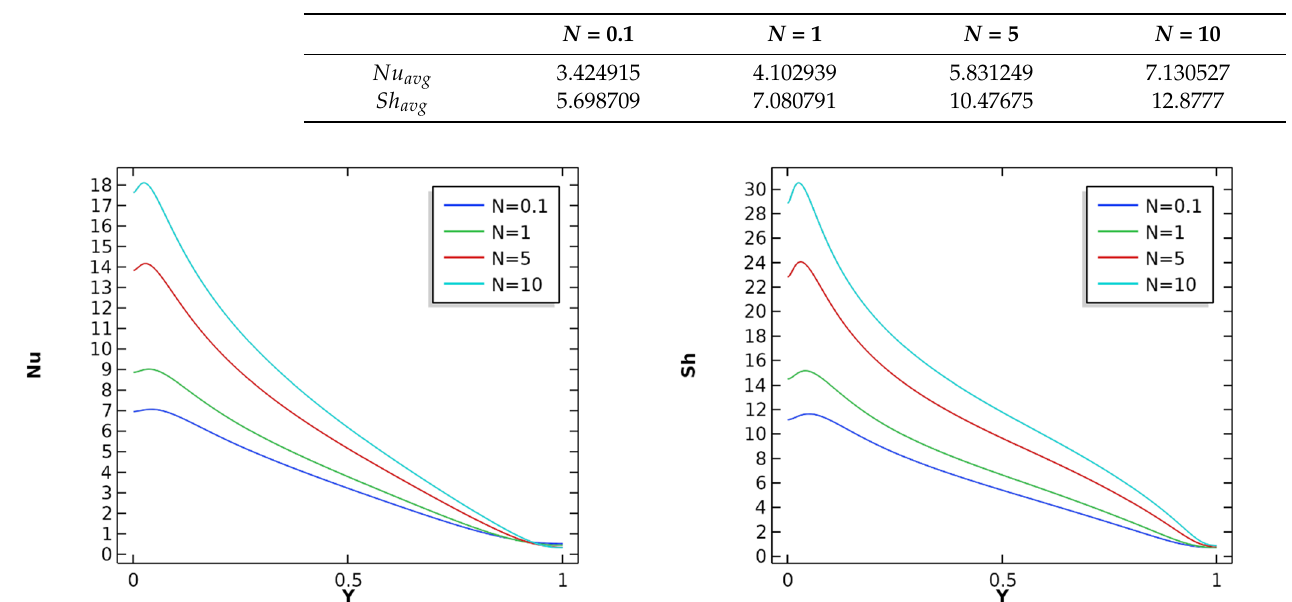
Figure 12. Variation in local Nu and Sh . Table 6. Average Nu and Sh comparison.